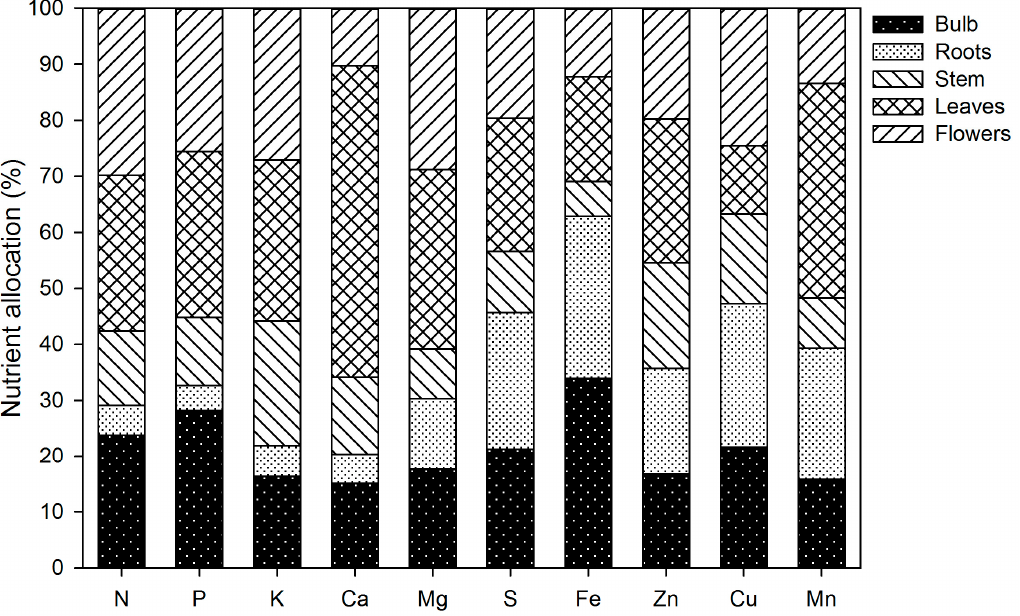
Figure 12. Nutrient allocation to the di ff erent plant parts of lilium at the end of the growing season.